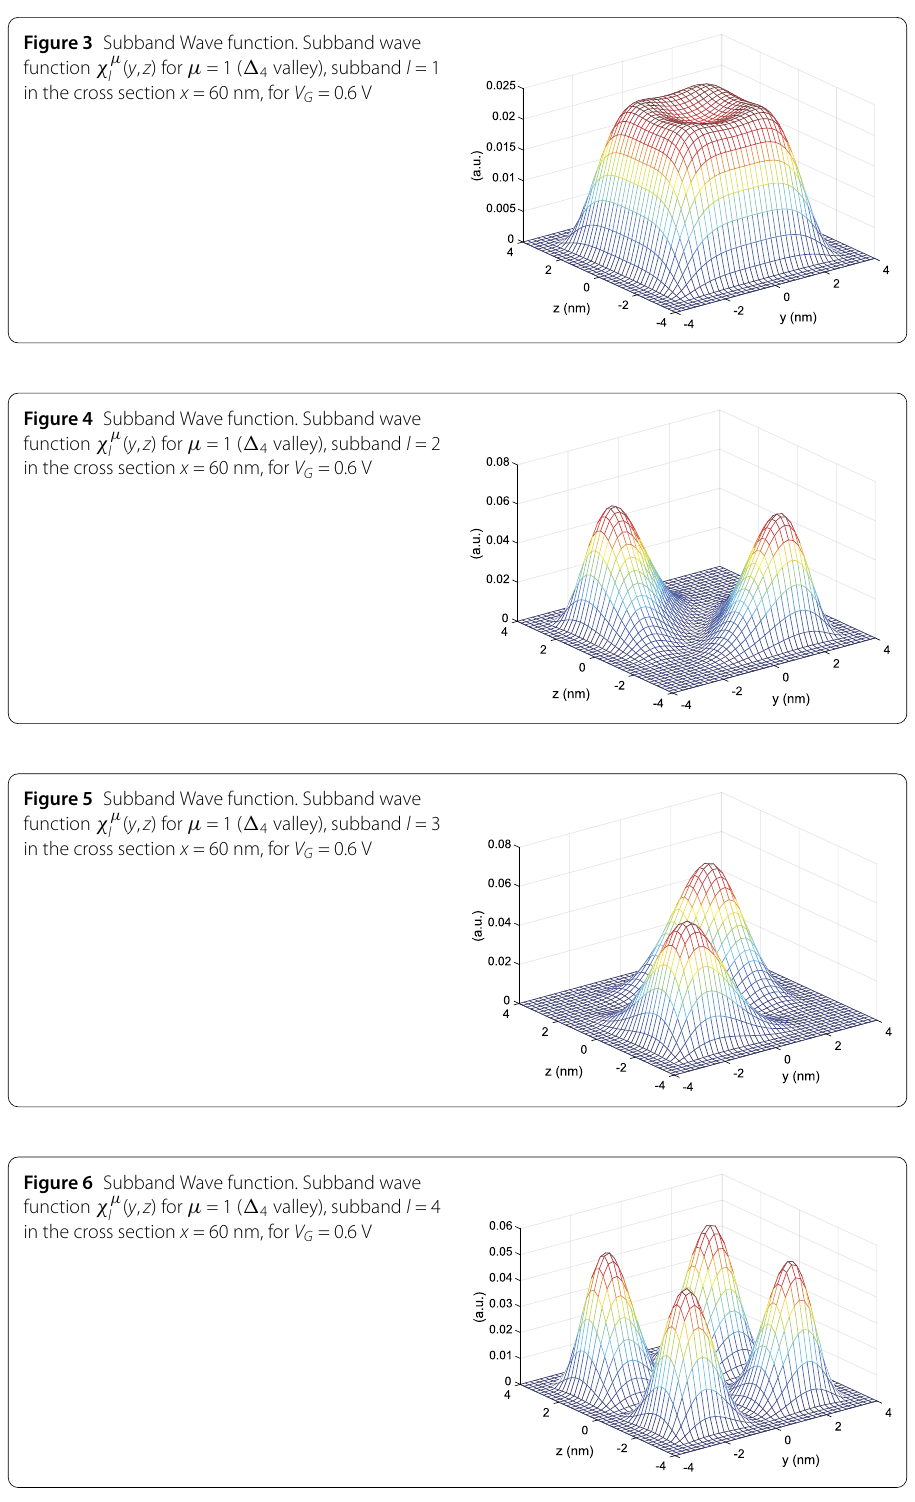
The electron density (2) 4 in the cross section x = 60 nm, perpendicular to the transport direction, is shown in the Figs. 7, 8, 9 for V G = 0.16,0.6,1 V respectively. For small gate voltage, the volume charge is peaked in the center of the wire as shown in Fig. 7. As